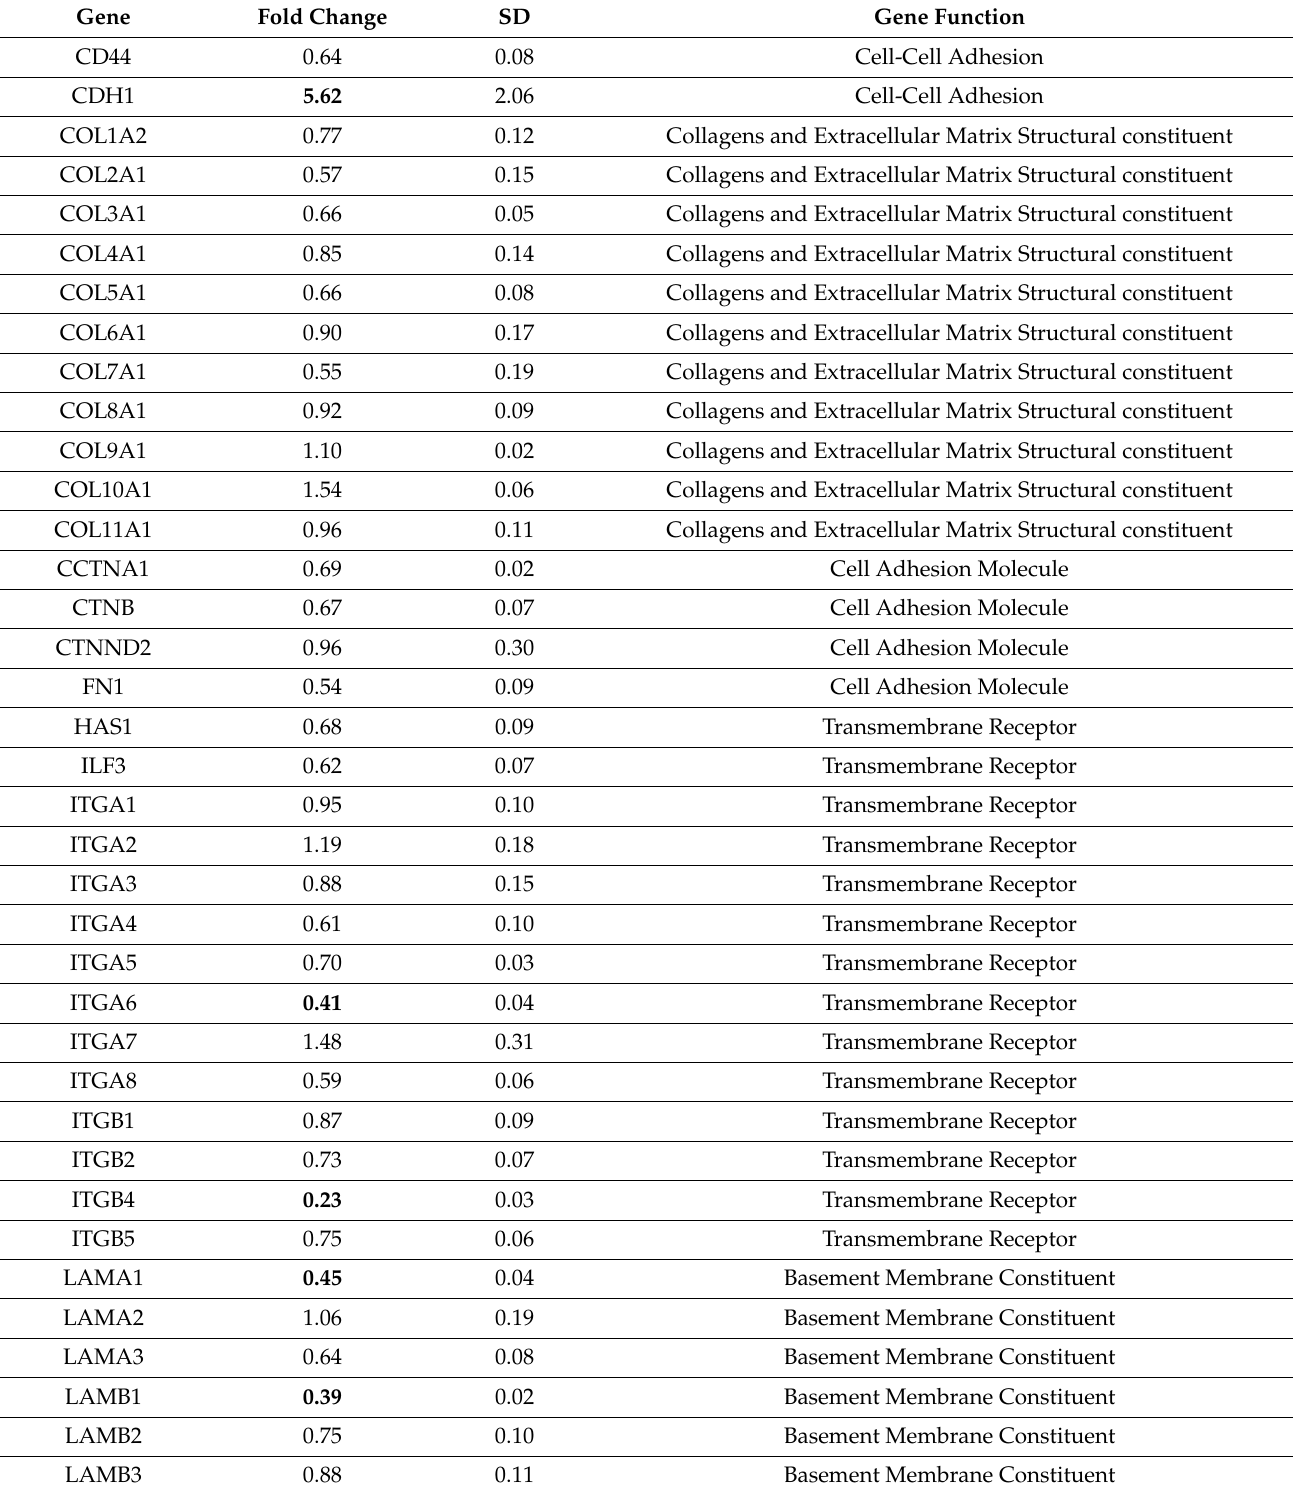
Table 1. Genes belonging to the “Extracellular Matrix and Adhesion Molecules” pathway analyzed using real-time Polymerase Chain Reaction. Fold changes represent the expression levels of genes after 24 h treatment with nifedipine, as compared with untreated cells ( n = 3). SD = standard